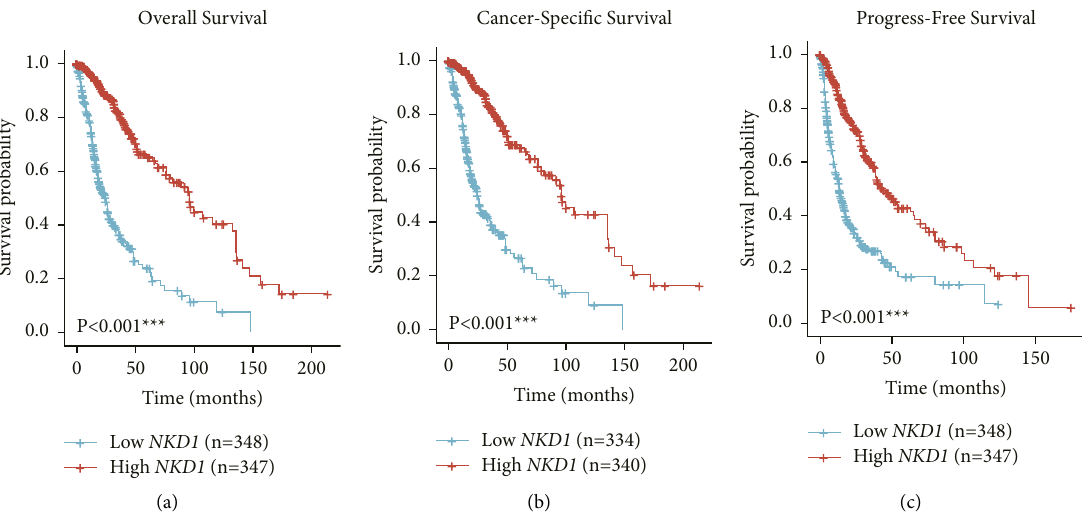
Figure 2: Survival analyses of glioma patients based on the mRNA level of NKD1. Te survival analyses were conducted using the Kaplan–Meier method according to the TCGA dataset, which refected that higher-NKD1 mRNA level was correlated with better overall survival (a), cancer-specifc survival (b), and progress-free survival (c) of glioma patients. Data were compared by log-rank